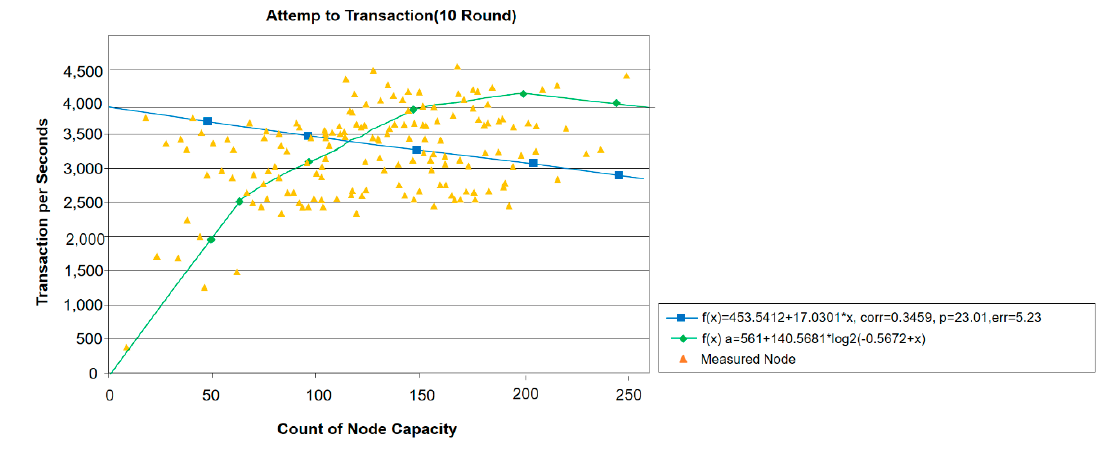
Figure 10. Experimental method (average value of Experiment 10 Round).